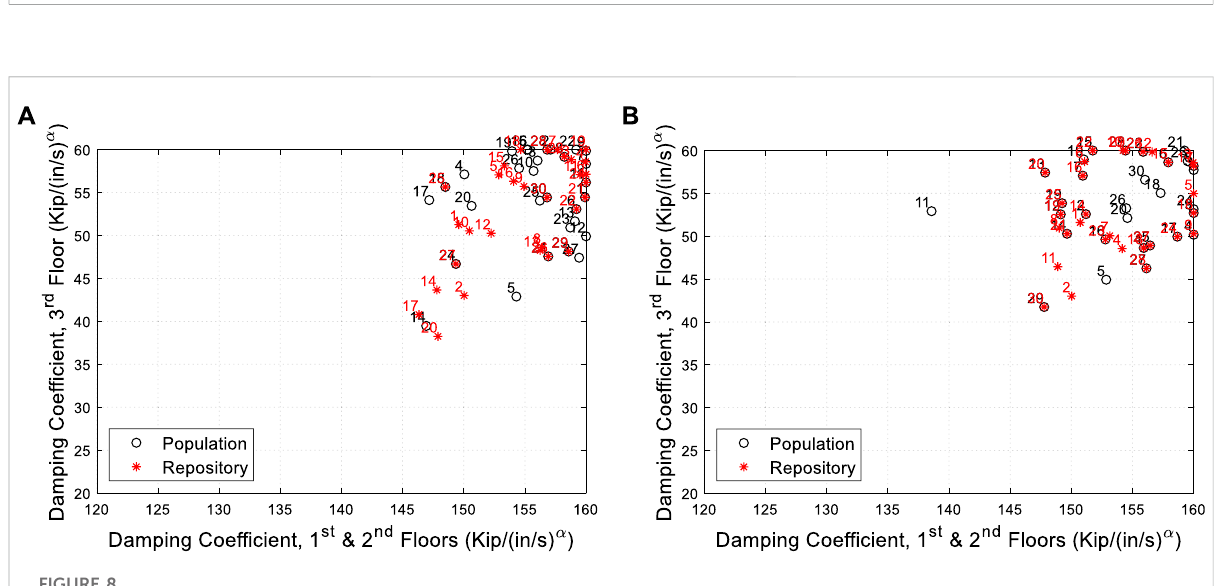
Frontiers in Built